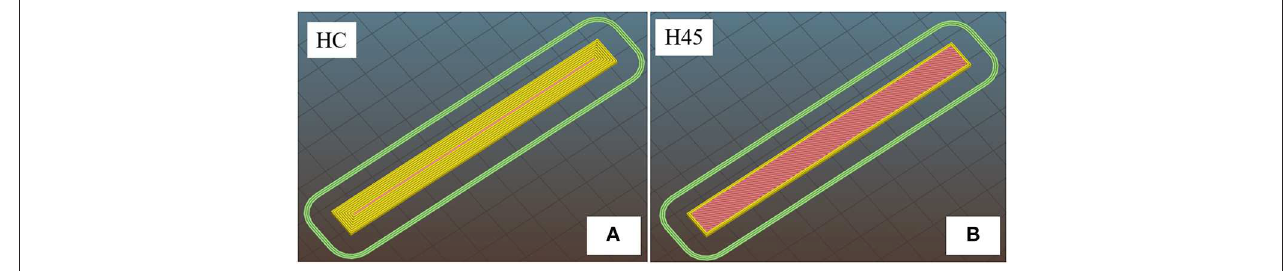
FIGURE 1 | Schematic of 3D-printed parallelepiped: (A) horizontal concentric (HC) and (B) horizontal 45 ◦ angle (H45).